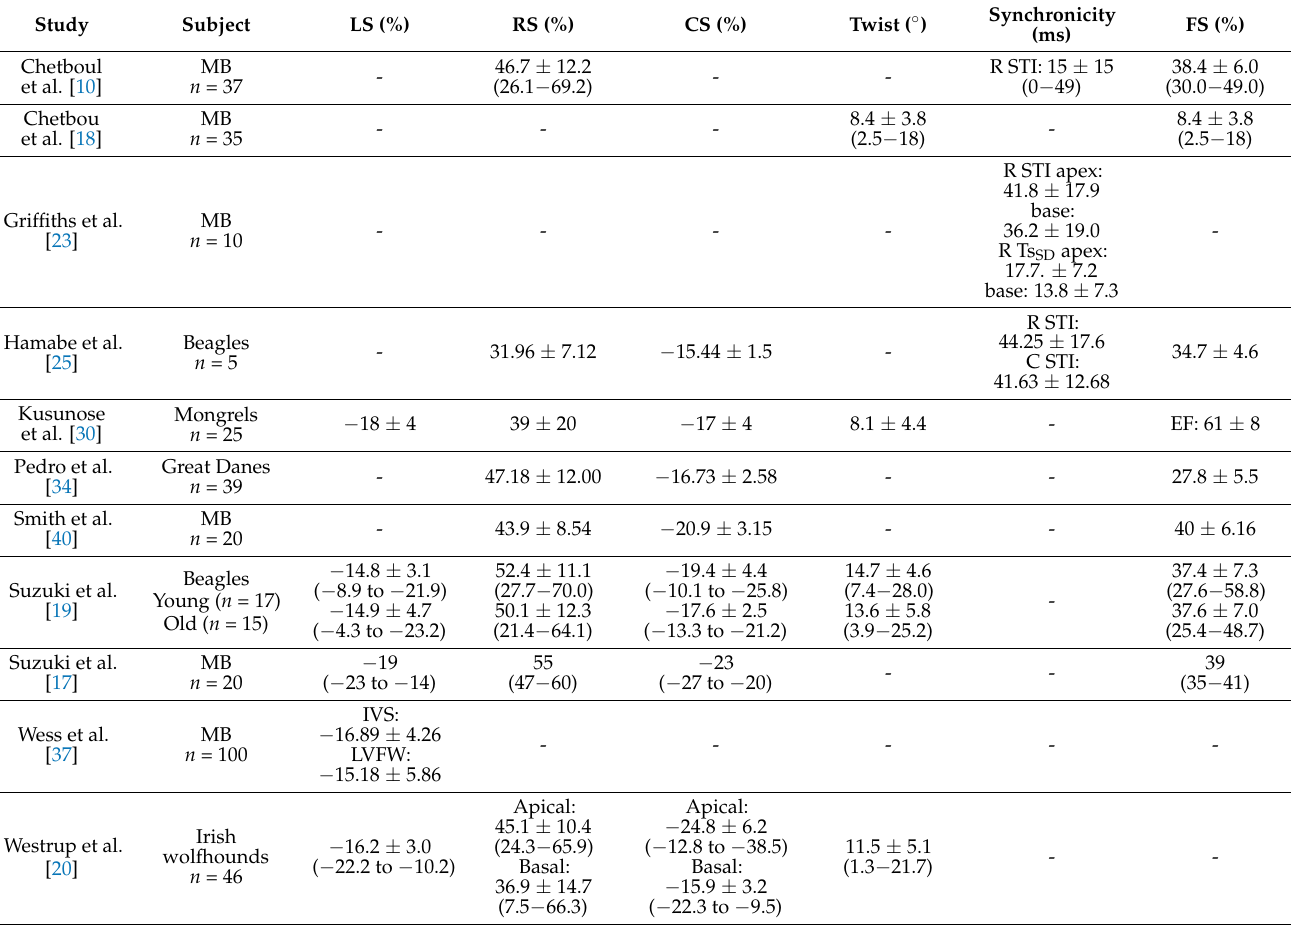
Table 2. Normal values of two-dimensional speckle tracking echocardiography (2D–STE) in clinically healthy